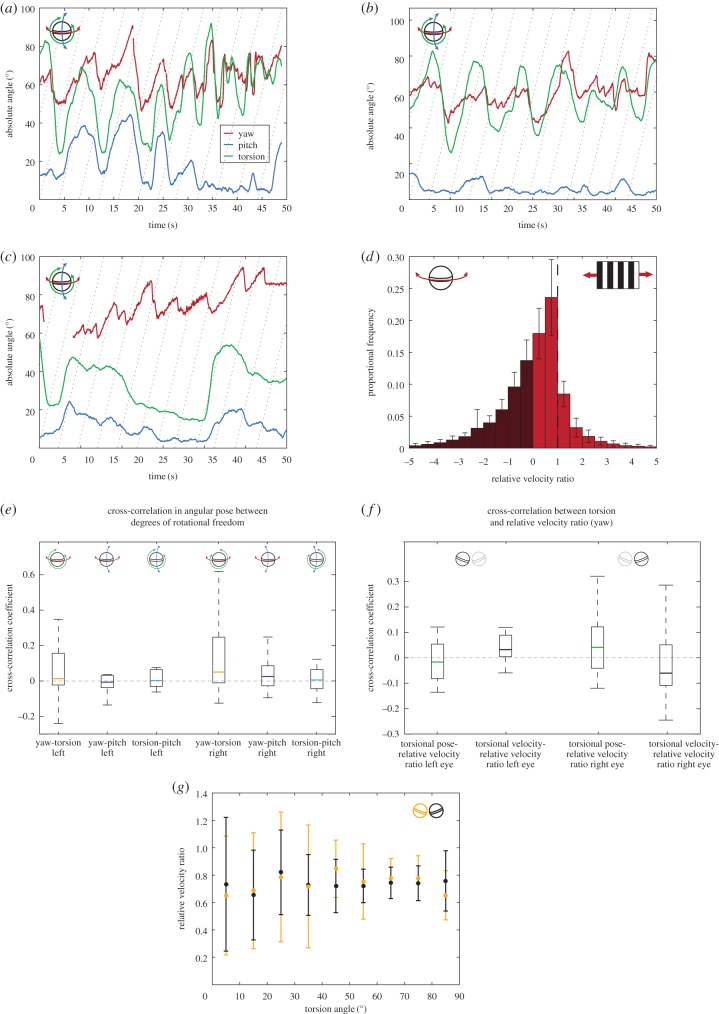
(a–c) The three-dimensional rotational response (yaw (red), pitch (blue) and torsion (green)) of the left eye of a single stomatopod during three separate trials in which the striped drum rotated anticlockwise in the yaw plane, producing a horizontally moving field of view. (d) The distribution of relative velocity ratios during the fast and slow phases of yaw optokinesis across the left and right eyes of 17 O. scyllarus during presentation of the drum rotating in both directions. Dashed vertical line indicates ‘perfect’, idealized gaze stabilization (SY = 1). SY > 0 when the eye is yawing in the same direction as the drum and SY < 0 when yawing in the opposite direction (dark red region), as occurs during fast resets (n = 17, error bars are standard deviation across all animals in each 0.5 interval). (e) Distribution of the cross-correlation coefficients between the angular pose of each of the degrees of eye rotation during yaw-plane experiments showing non-significant correlation between yaw and torsion, yaw and pitch, and torsion and pitch for the left and right eyes (n = 17). Horizontal dashed line indicates a cross-correlation coefficient of 0. (f) Boxplot of the cross-correlation coefficients between the relative velocity ratio in the yaw degree of freedom and the torsional rotation of the left and right eyes during yaw-plane experiments. Yaw gaze stabilization performance is independent of both torsional pose and velocity of torsional rotation. Horizontal dashed line indicates a cross-correlation coefficient of 0. (g) Median values of relative velocity ratio in 10° intervals as the left (orange) and right (black) eyes rotate torsionally from horizontal (0°) to vertical (90°) (n = 17, error bars are the standard deviation across all animals in each 10°interval).